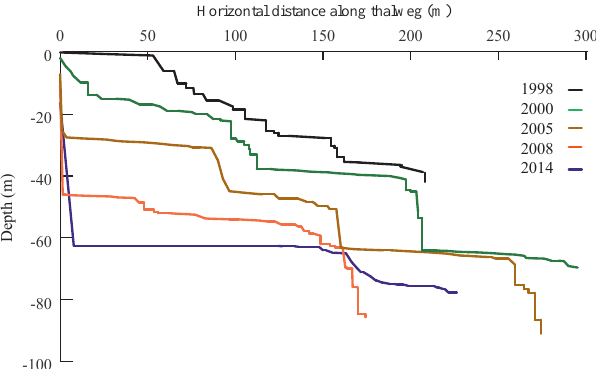
Figure 3. Longitudinal profiles of the englacial channel for indi- vidual surveys; all depths are referenced to the 1998 entry location. The data from 2004 are not shown due to significant uncertainty in the position of the entry point relating to the access location through seasonal snow cover. Note that the x axis shows distance measured along the thalweg, not true horizontal distance. Included are data from a resurvey of the conduit in spring 2014 (see Myreng,